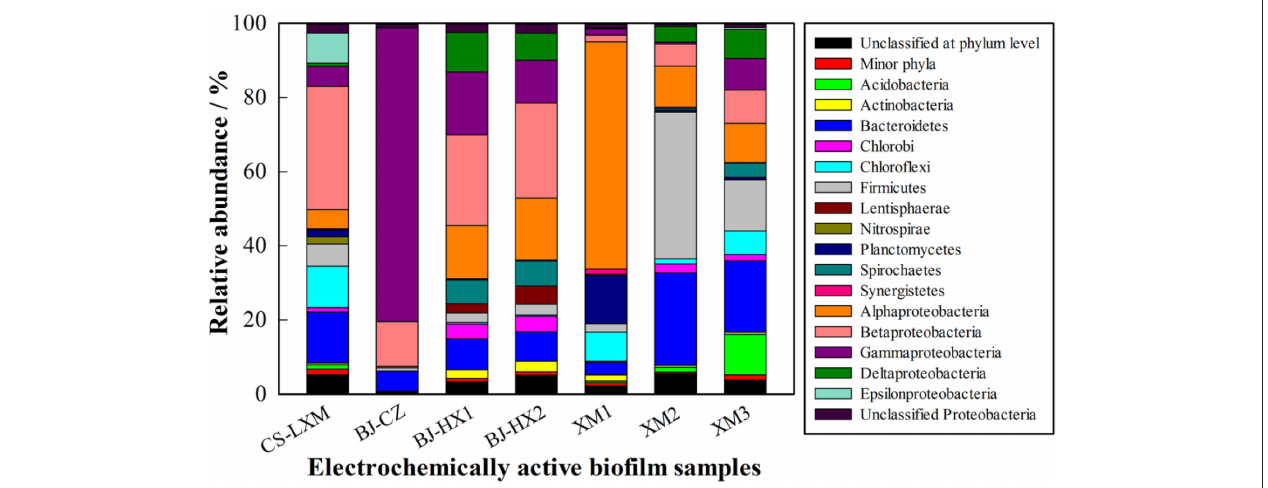
FIGURE 1 | Relative abundances of major phyla ( > 1% in at least one sample) and classes in Proteobacteria in the 7 EAB samples. The relative abundance is presented as the percentage in 30269 effective sequences in each sample. Minor phyla refer to taxa with a maximum relative abundance < 1% in any sample.